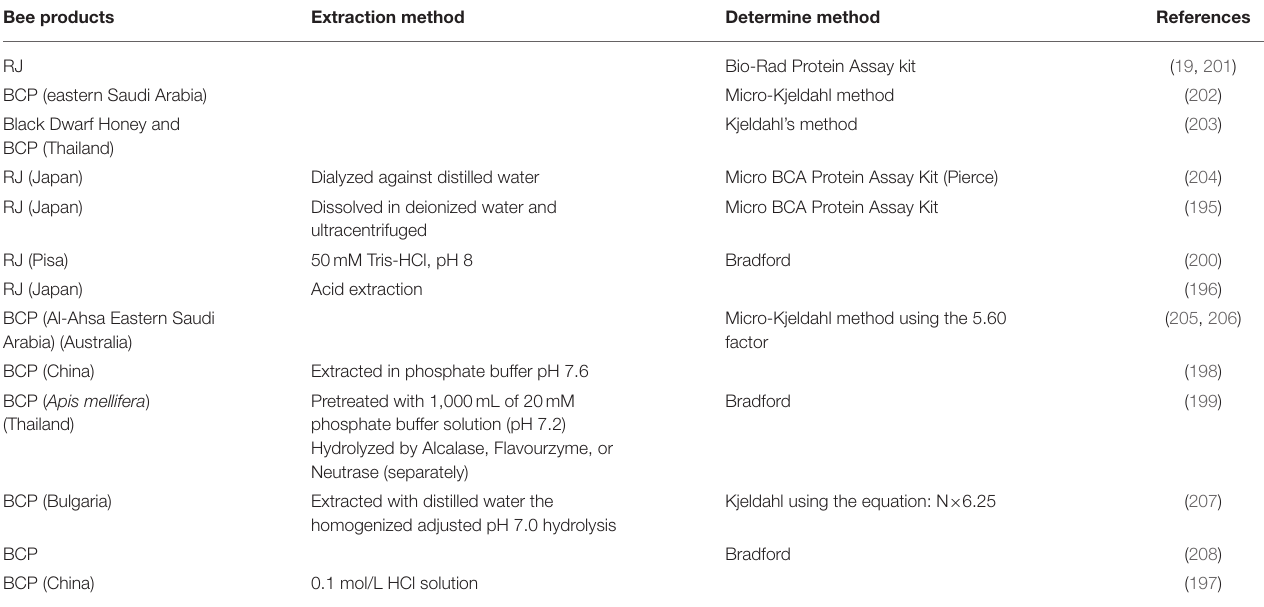
TABLE 4 | The techniques for the protein extraction and